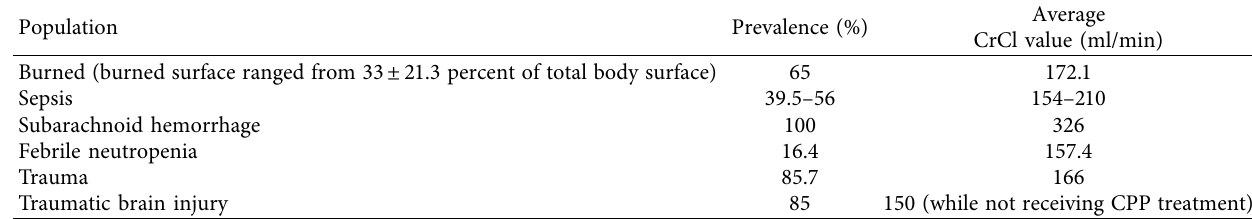
Table 1: Populations at risk of RHF. Adapted from Cook and Hatton-Kolpek [1].